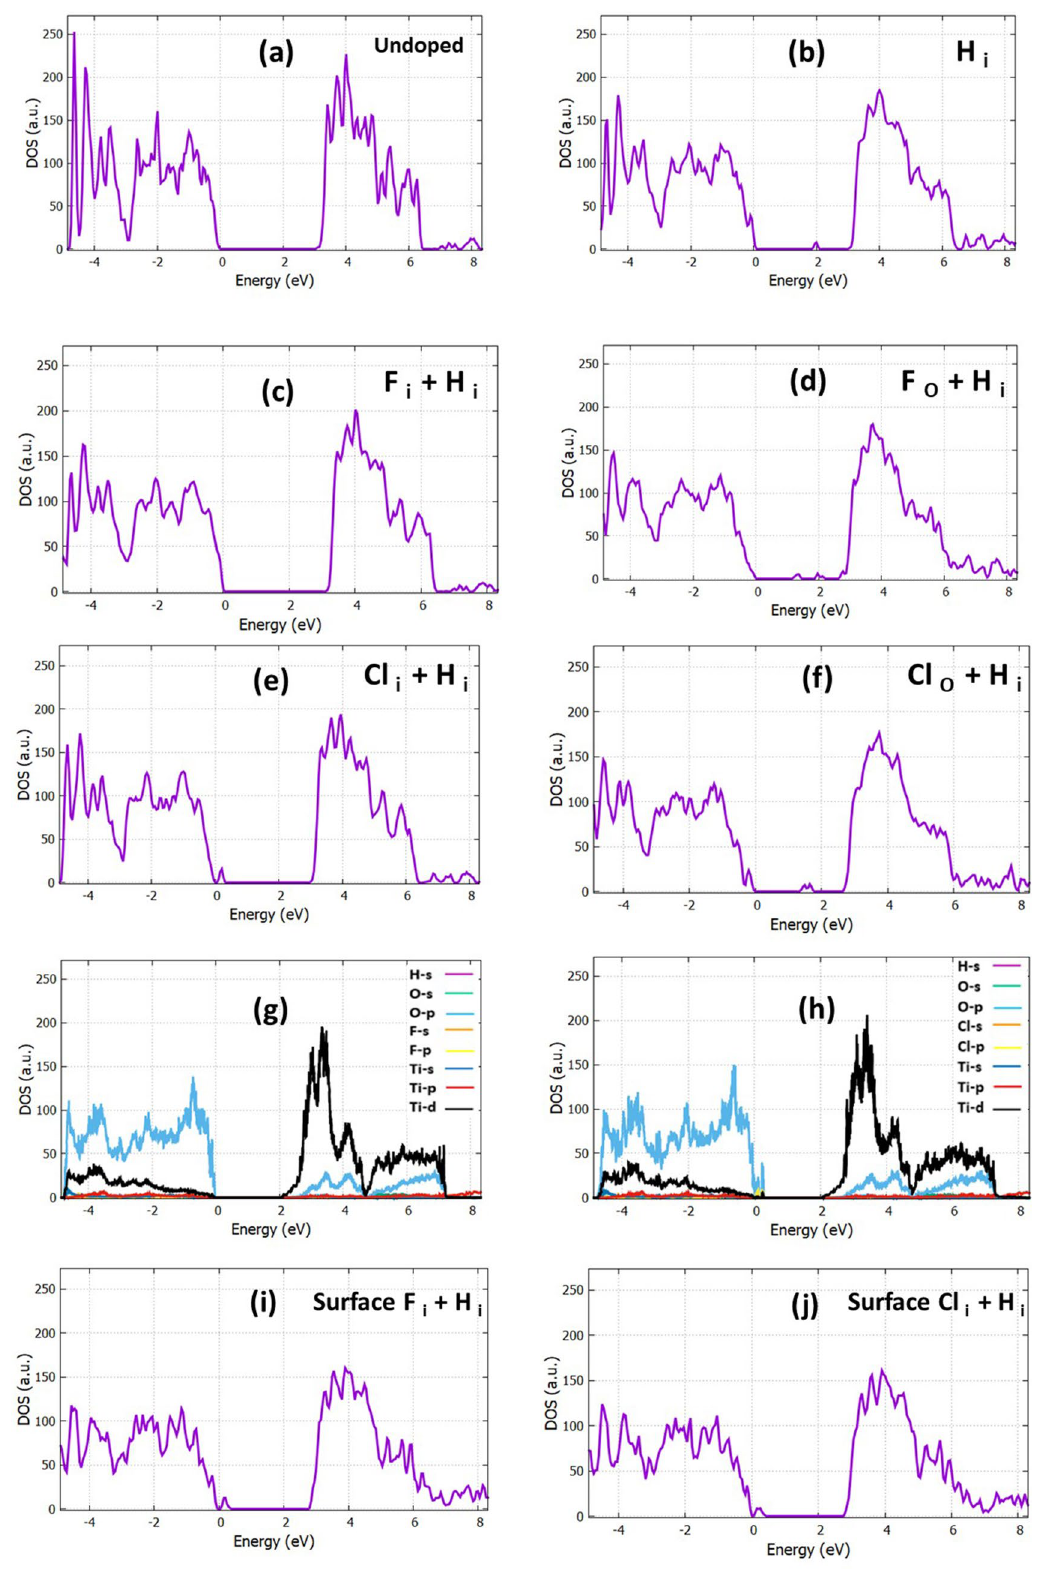
Figure 3. The DOS of ( a ) TiO 2 , ( b ) H i :TiO 2 , ( c ) F i :H i :TiO 2 , ( d ) F o :H i :TiO 2 , ( e ) Cl i :H i :TiO 2 and ( f ) Cl o :H i :TiO 2. The projected DOS of interstitial doped structures ( g )